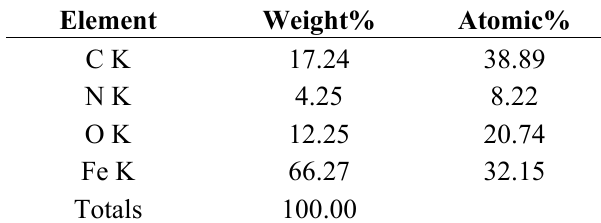
Table 2 EDS of chitosan- g -poly(4-vinylpyridine)/Fe 3+